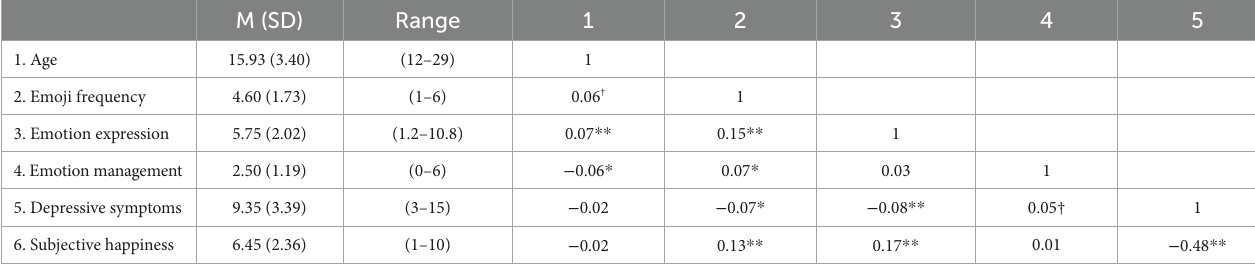
TABLE 2 Descriptive statistics and inter-correlations among